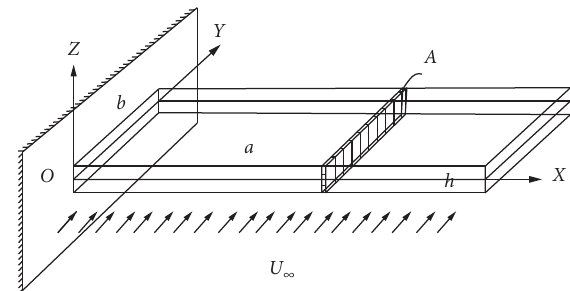
Figure 1: Model of the high-aspect-ratio cantilever